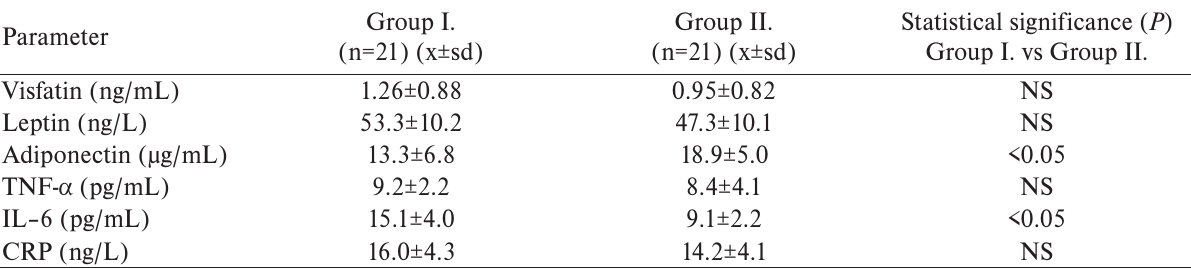
Table 2. Selected adipocytokines and cytokines before surgery in Group I and Group